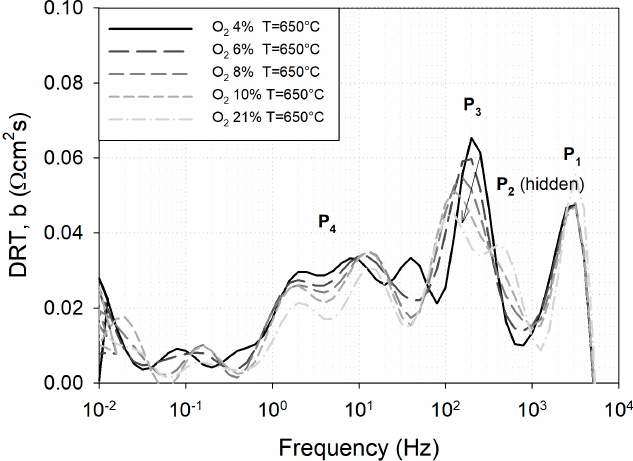
Figure A3. Effect of oxygen variation on the DRT spectra.